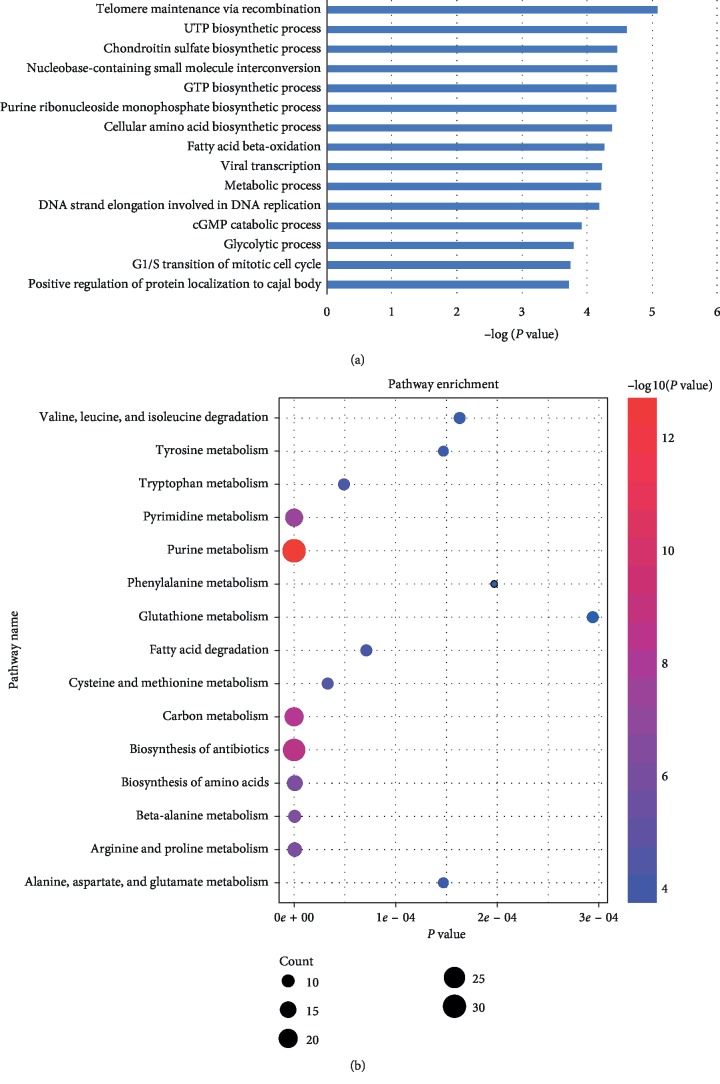
Gene ontology and pathway enrichment analysis of rewiring metabolic genes in cancer tissues compared to normal. (a) The gene ontology analysis; P < 0.01. (b) The KEGG pathway enrichment analysis; P < 0.01. The top 15 pathways were chosen and analyzed. The size of the circle indicates the number of enriched genes.